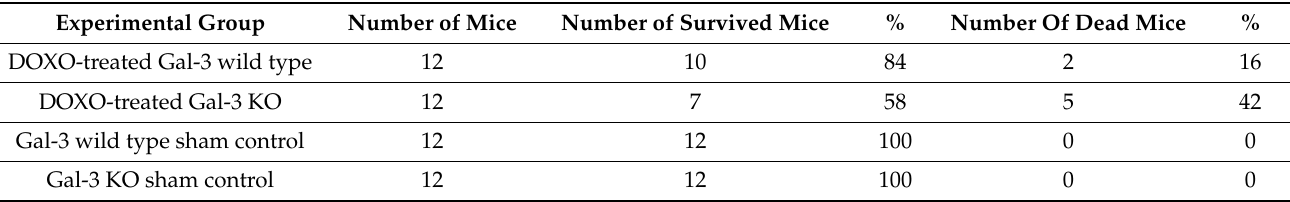
Table 1. Survival and mortality rates in experimental